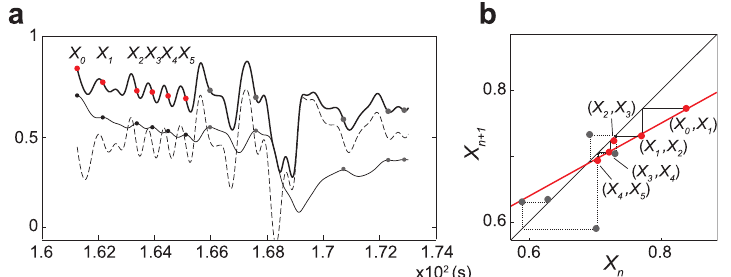
Figure 3. Procedure for depicting the return map from the time series of state variables. ( a ) Gray, broken, and black lines show the time series for normalized X IPD ( t ) , normalized V IPD ( t ) , and X ( t ) , respectively, for a 12-s trial with more than five peaks. The red and gray circles indicate the corresponding values of X ( t ) for the peaks of X IPD ( t ) . ( b ) Return map of the time series for the observed data, X n vs. X n + 1 using the amplitude of X ( t ) at the peaks of X IPD ( t ) corresponding to the series of points (red and gray circles) in the panel shown in a . Modified from